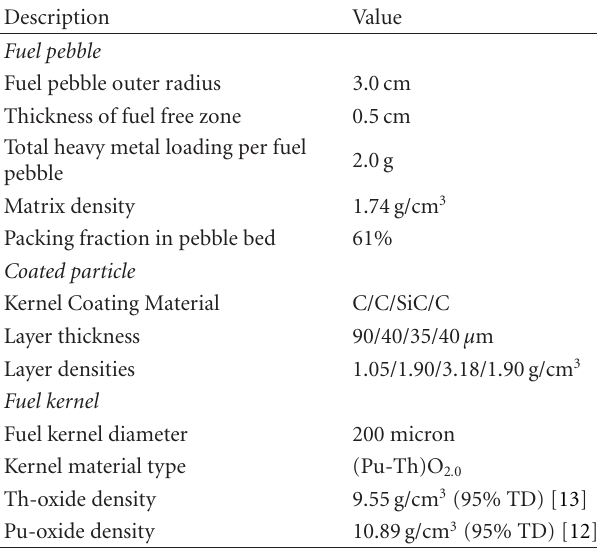
Table 2: (Pu-Th)O 2 fuel general characteristics in accordance with PUMA Project [10, 11].